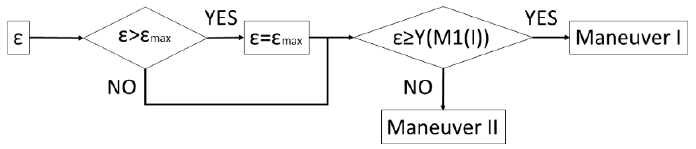
Figure 5. Car parking maneuver type decision algorithm.